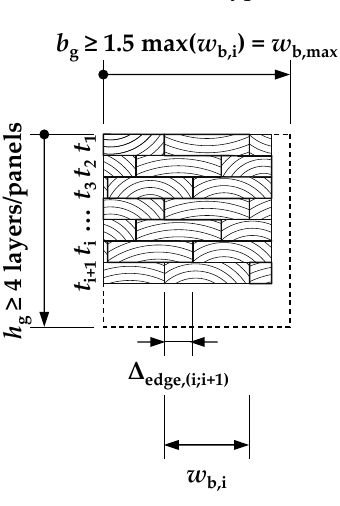
Figure 32. Requirements on the cross-section of flex_GLT type B beams.